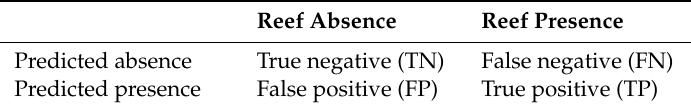
Table 2. Contingency table for reef presence-absence